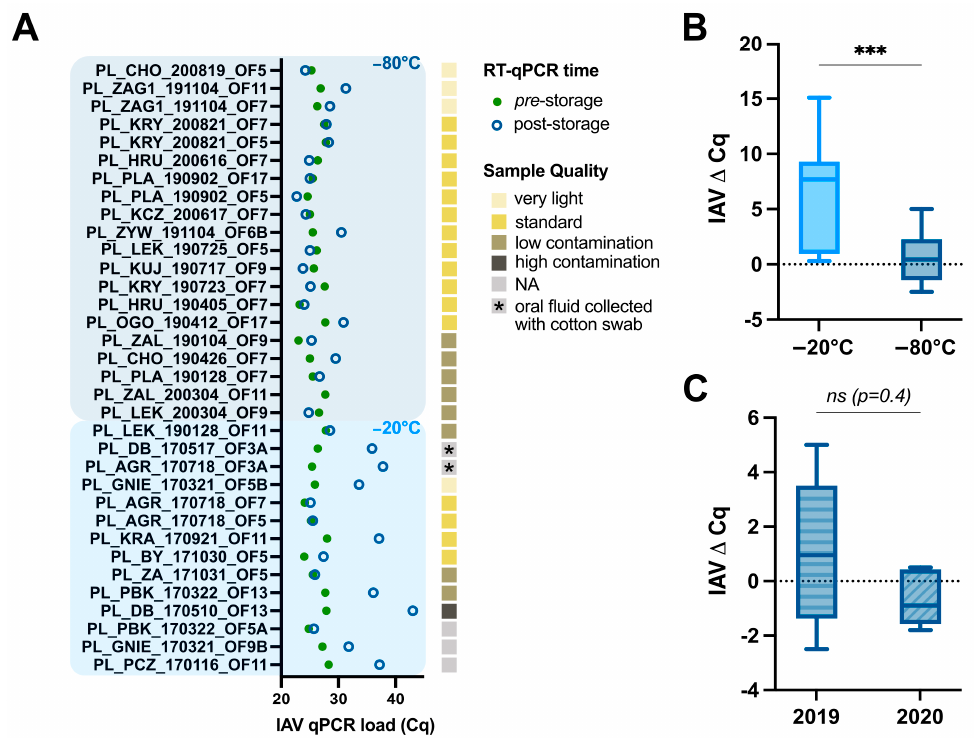
Figure 1. Impact of storage temperature, storage time, and oral fluid sample quality on IAV RT-qPCR detection. ( A ) Overview of IAV RT-qPCR detection of 34 oral fluid samples collected from 19 different Polish farms collected between 2017 and 2020. Samples have been categorized by their original storage temperature ( − 22 °C and − 80 °C shaded in light and dark blue, respectively). Differences in detection (RT-qPCR) for IAV are shown as Cq values pre-storage (solid green circles) and post-storage (open blue circles). Visual inspection of sample qualities is represented as yellow-to-brown shaded boxes for each sample. NA indicates no data were available. ( B ) Box-and-whisker representation (min. to max.) of all samples as categorized based on initial storage temperature, including 13 and 21 samples for the − 22 °C and − 80 °C groups, respectively. ( C ) Box-and-whisker representation (min. to max.) of all − 80 °C-stored samples (n = 21) further categorized by year of collection and storage. Seven and fourteen samples originated from 2019 and 2020, respectively. Statistical analyses were performed using a nonparametric Wilcoxon matched-pairs signed-rank test with a p < 0.05 significance cut-off; *** p < 0.001, ns = non significant.